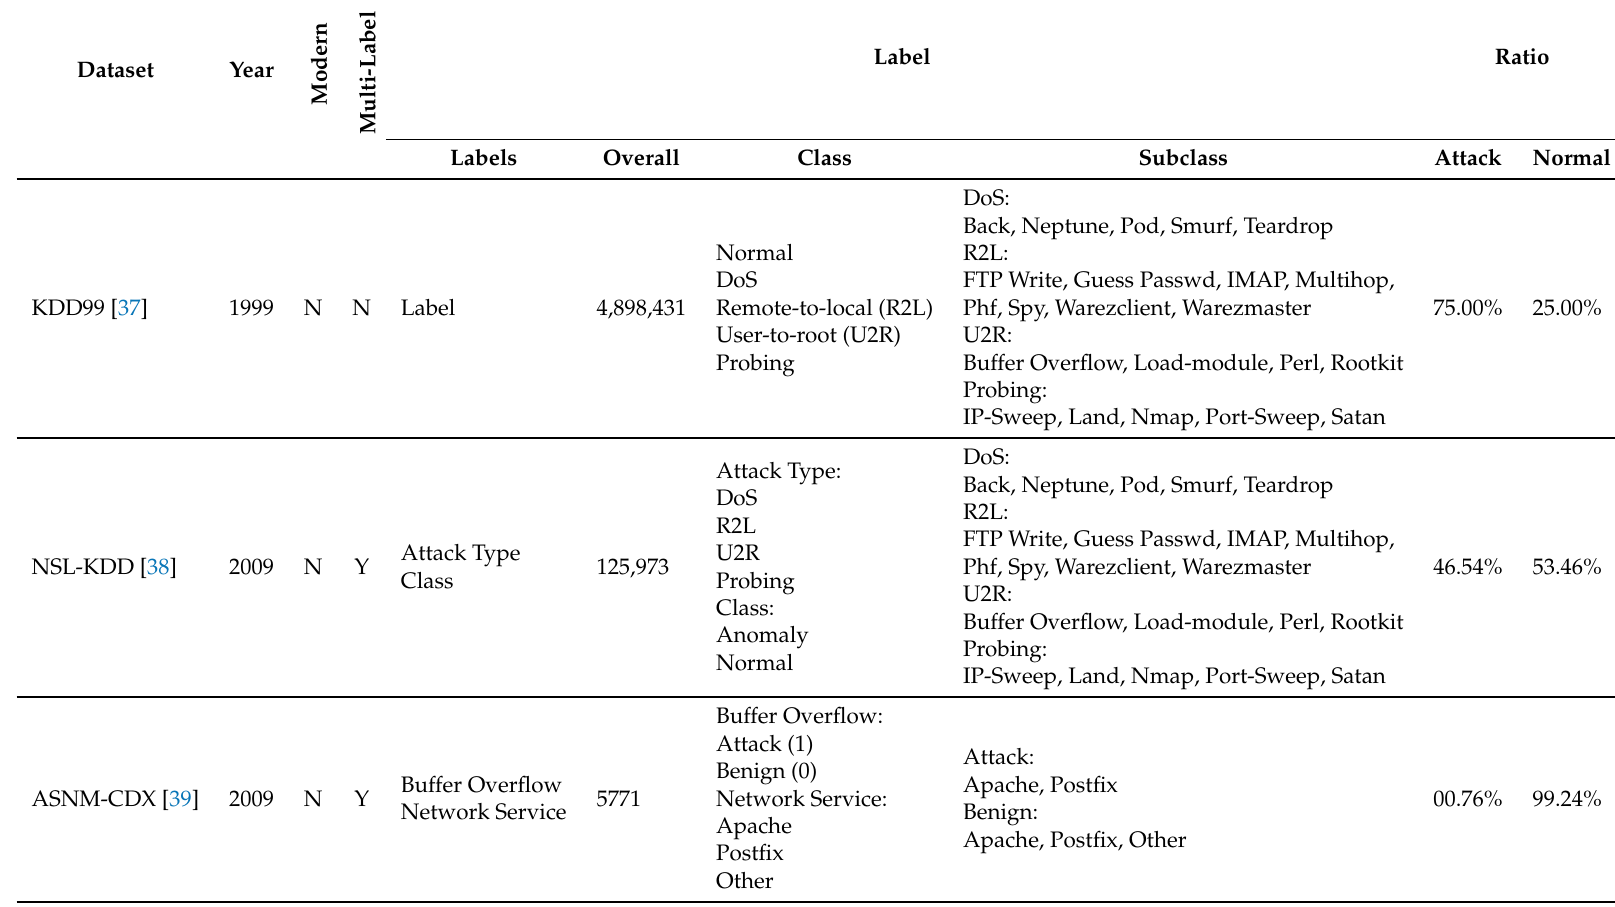
Table 2. Comparison between the most common datasets for